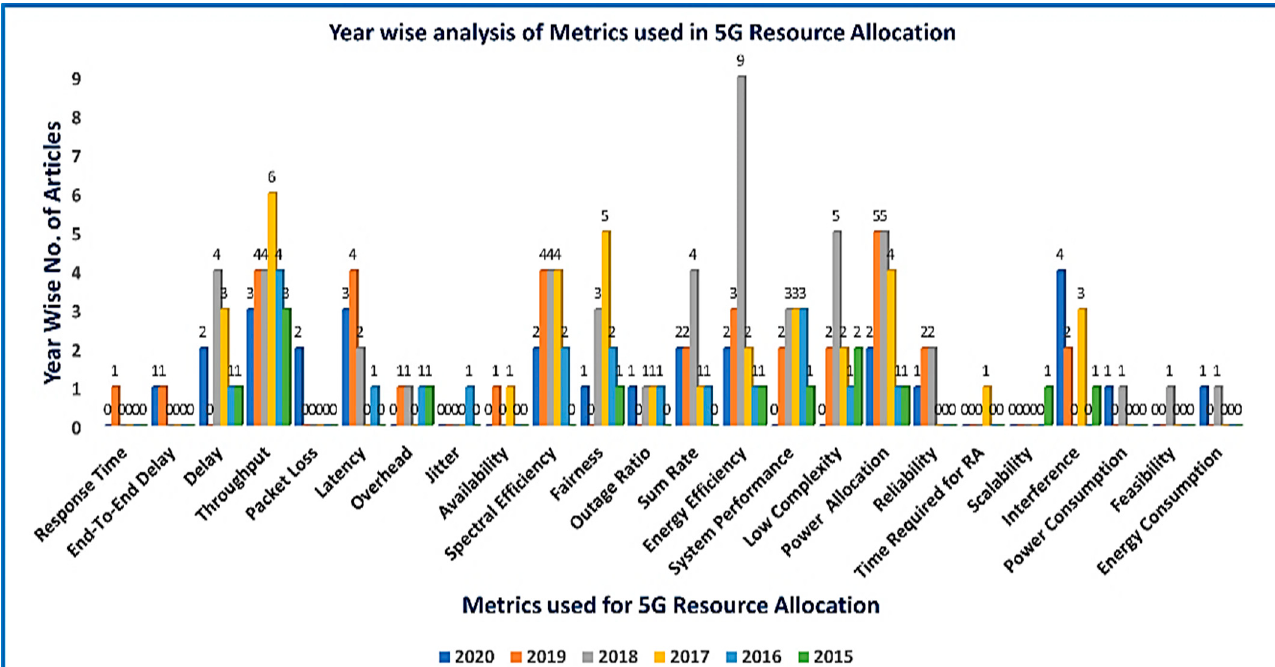
Figure 8. Year-wise analysis of metrics used in 5G resource allocation.